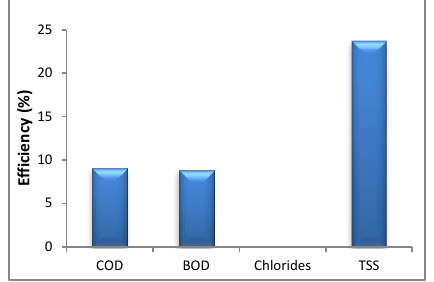
Figure 2: Efficiency of Anaerobic Pond